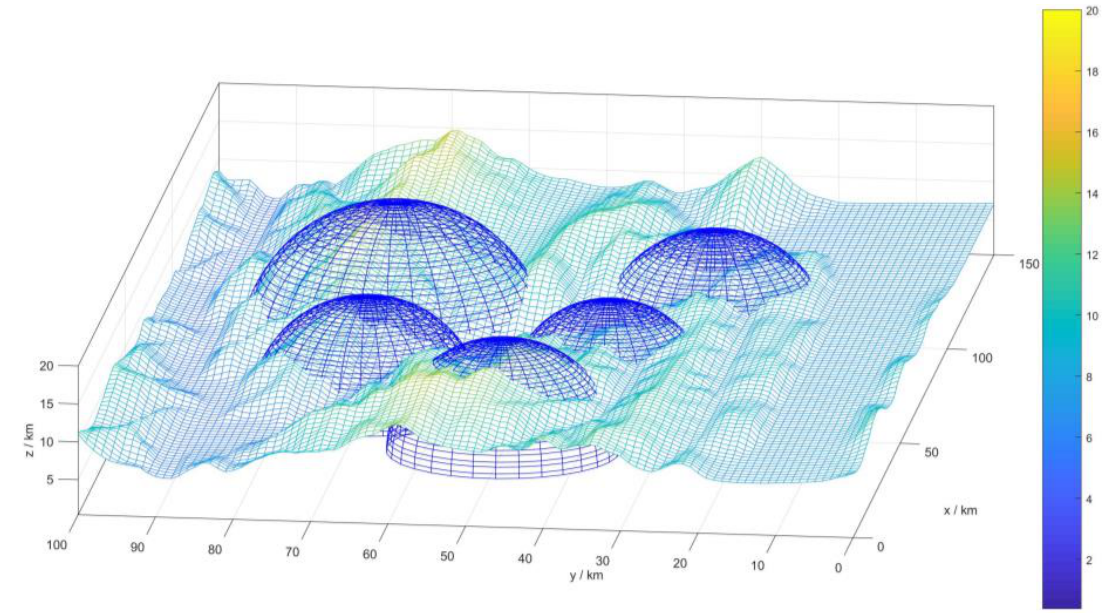
Figure 1. 3D digital map.